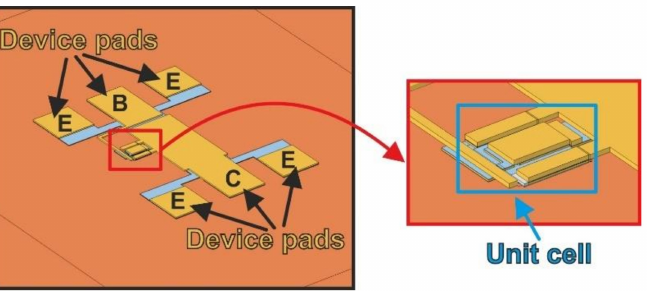
Figure 4. ( Left ) Single-cell test device built in the COMSOL environment ( draw mode ); as can be seen, the pads are arranged in a ground-signal-ground configuration to allow for RF experimental characterization. ( Right ) Magnification of the unit